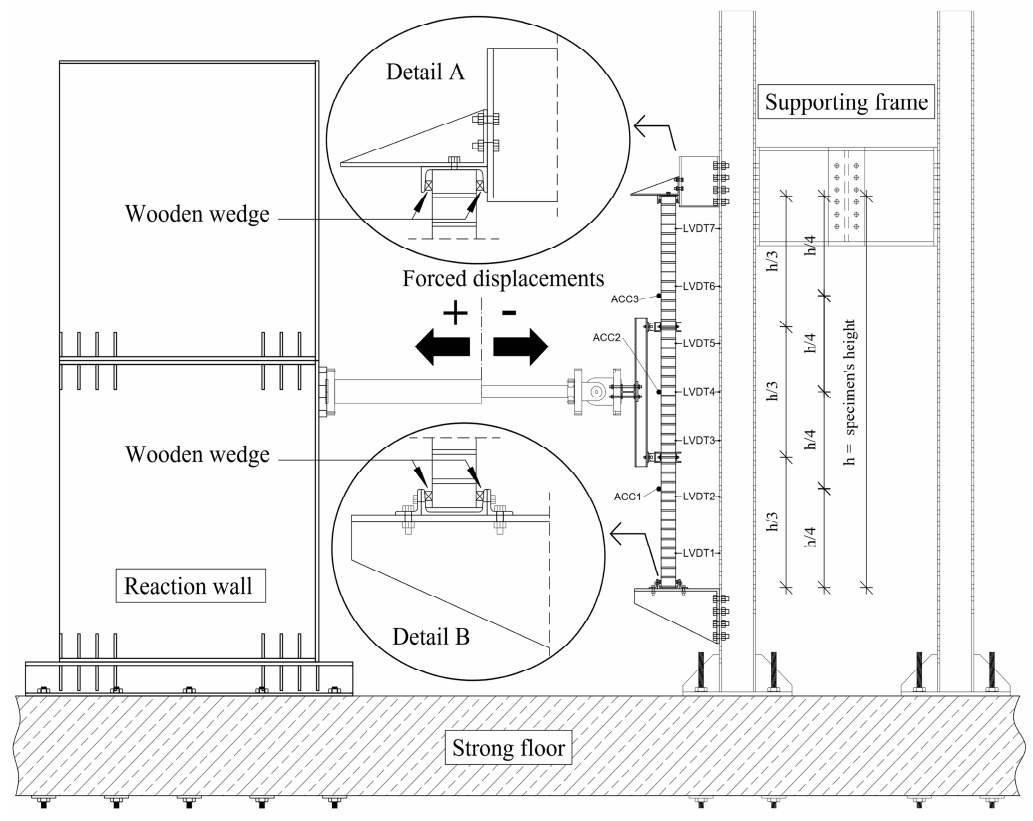
Figure 3. Quasi-static cycling test setup for out-of-plane testing of non-structural wall